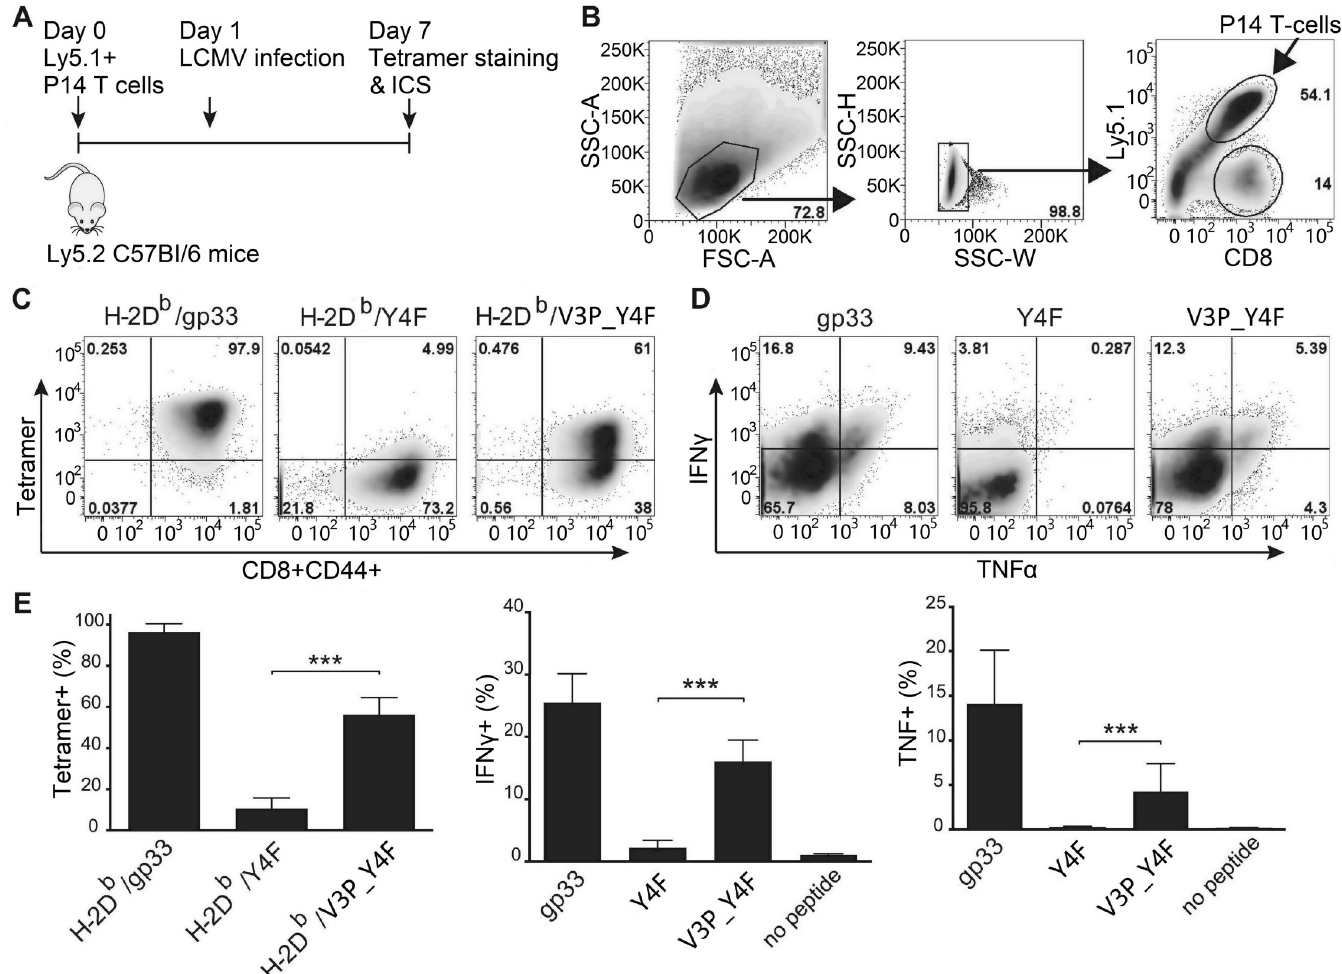
Fig 2. The p3P modification increases significantly P14 T cell responses. A. C57/Bl6 mice were adoptively transferred with 10 4 P14 T-cells one day prior to infection with LCMV. Mice were sacrificed on day 7 post T cell transfer. T-cells from spleen were stained with PE-conjugated H-2D b /gp33, H-2D b /Y4F or H-2D b /V3P_Y4F tetramers. T cells were also stimulated with gp33, Y4F or V3P_Y4F peptides (10 − 6 M) for 5h, prior to assessment of intracellular IFN γ and TNF expression levels. B. Gating strategy used to detect CD8 + CD44 + cells. P14 T cells were distinguished from endogenous T-cells using the Ly5.1 (V450) marker. C. Representative density plots from tetramer staining. CD8 + CD44 + P14 T-cells were stained with H-2D b /gp33 (left), H-2D b /Y4F (middle) and H-2D b /V3P_Y4F (right) tetramers. D. Representative ICS density plots. P14 T-cells were stimulated with peptides gp33 (left), Y4F (middle) or V3P_Y4F (right). E. CD8 + CD44 + P14 T-cells from the spleen were stained with the indicated tetramers on the x-axis (left). P14 T-cells from the spleen were stimulated with the peptides indicated on the x-axis, and expression of INF γ (middle) and TNF (right) was assessed. Error bars show mean +/- SD. One-way Anova was performed to compare between different groups. P-values � and ��� represent p < 0.05 and p < 0.001. The analysis was made using the GraphPad Prism